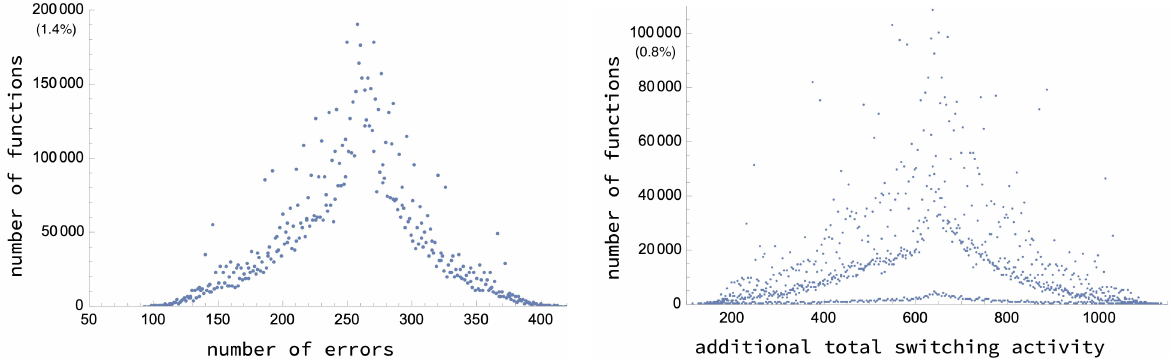
Figure 4. Tally counts according to the number of errors to MAJ and the additional total switching activity among 3 15 = 14,348,907 possible circuits using NAND, AND, and OR